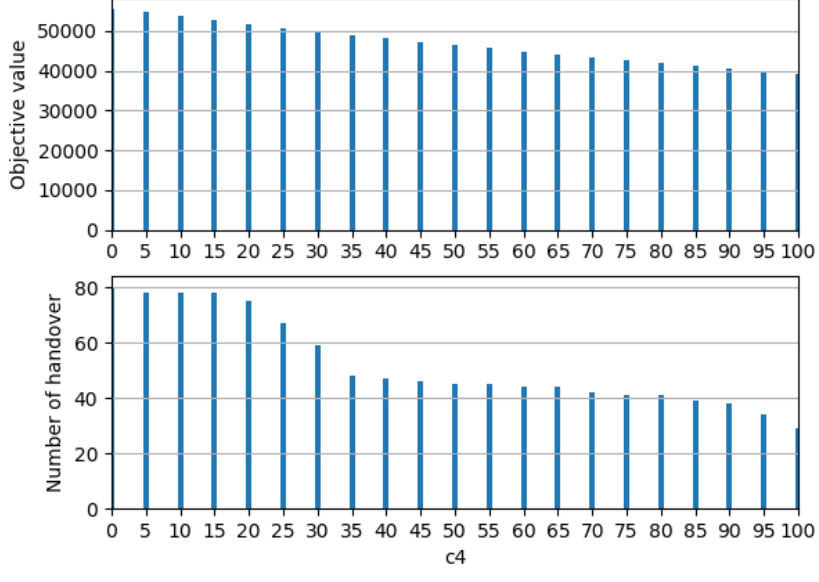
Figure 12. Sensitivity with respect to the penalty